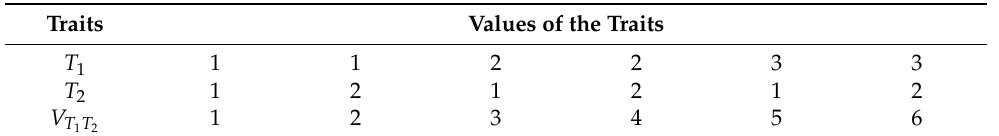
Table 5. An example how the values of a new variable V new = V T categories of traits T 1 with three and trait T 2 with 2 levels.